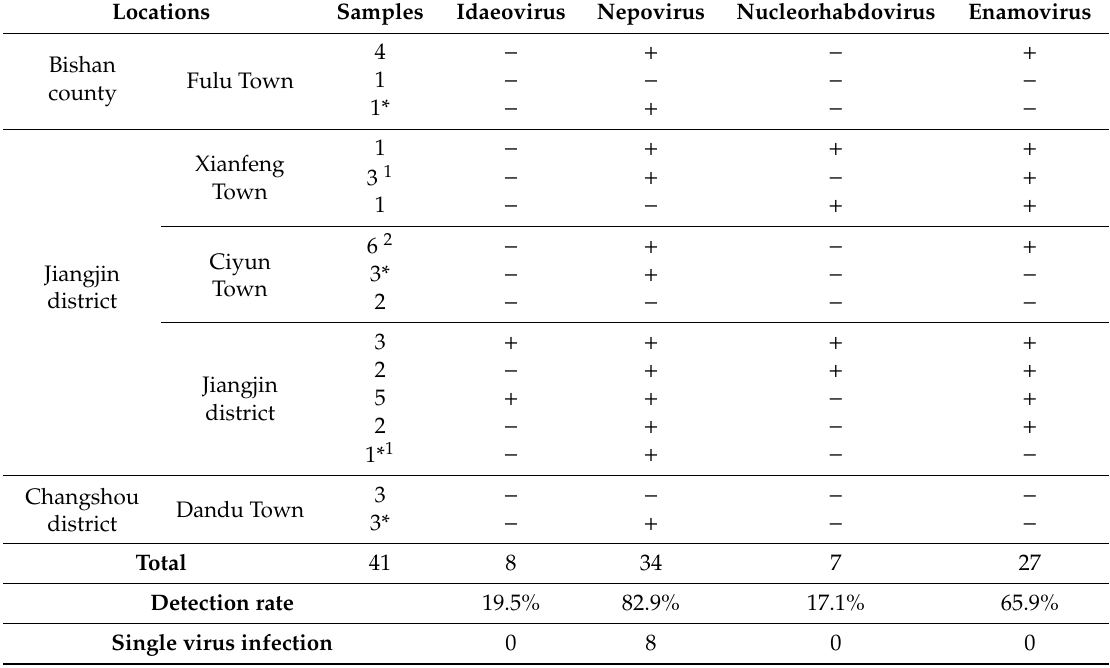
Table 2. Detection of viruses in the FYD-a ff ected green Sichuan pepper trees collected from Chongqing